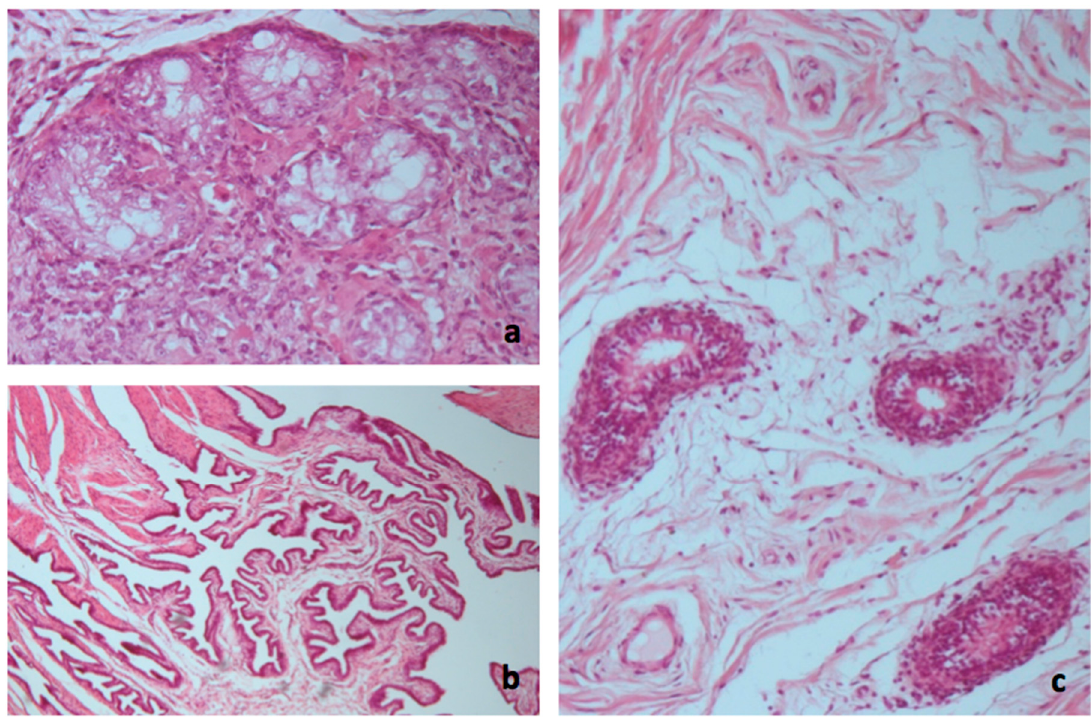
Figure 7. Histological examination. ( a ) Hypoplastic or atrophic seminiferous tubules, with thickening and hyalinization of the basement membrane and the presence of Sertoli cells. Complete absence of germinal epithelium. Leydig cells in the interstice with acidophilic cytoplasm (hematoxylon–eosin; ×250). ( b ) Infundibular portion of the salpinge at the level of the cranial pole of the gonads (hematoxylin–eosin; ×250). ( c ) Tubular structures covered with ciliated epithelium, referable to the epididymis or sketches of epoophoron or paroophoron (epididymis; hematoxylin–eosin; ×250).